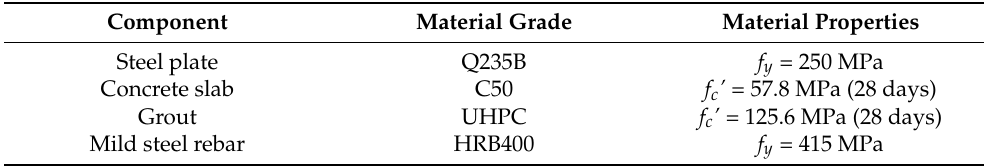
Table 2. Material properties for composite beam specimens.